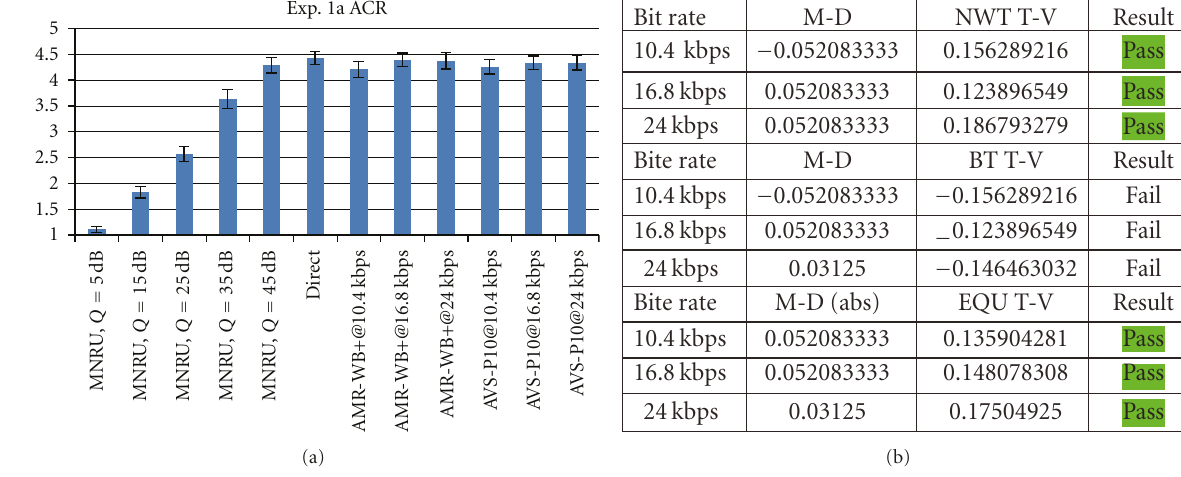
11.522.533.544.55